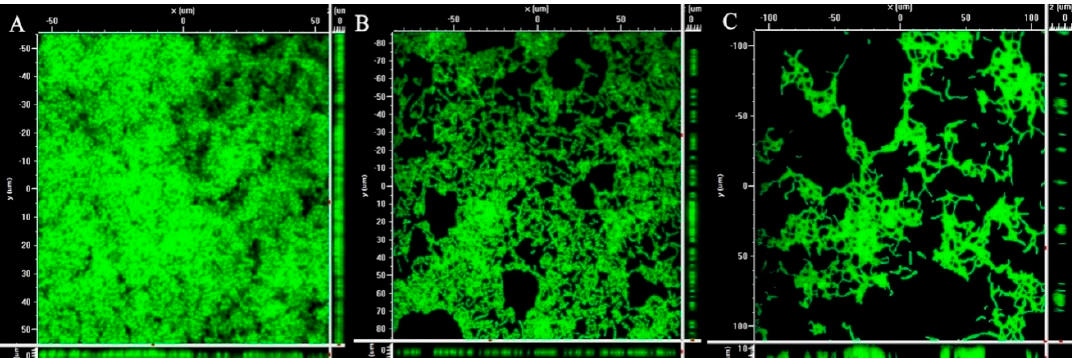
Figure 1. Biofilm analysis using confocal laser scanning microscopy: ( A ) Representative image of biofilm formed by S. mutans ATCC25175, ( B ) biofilm in the presence of crude dextranase from